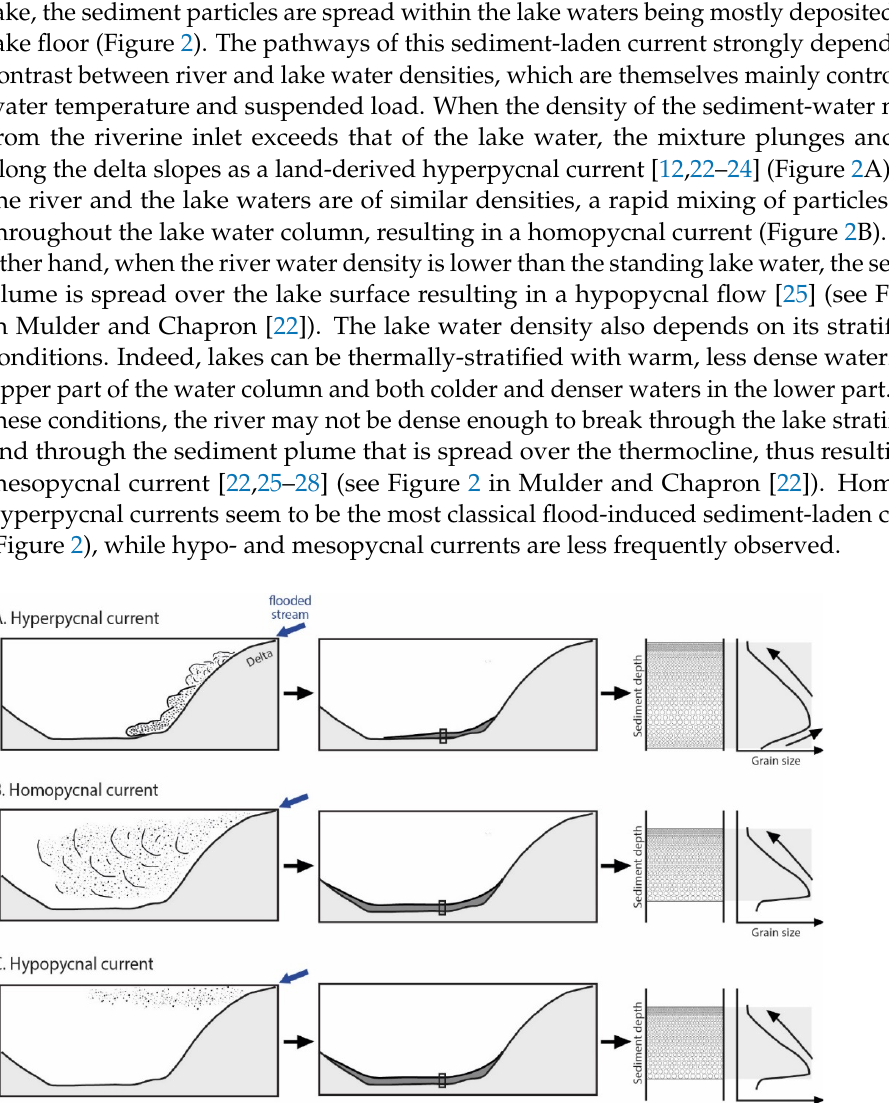
Figure 1. Map of the published paleoflood records from lake sediments and chronology of publica- tions covering all aspects of paleoflood hydrology from lake sediments (a publication in 1885 has been omitted for graphic reasons). A complete list of the published paleoflood records is available in Supplementary Material.